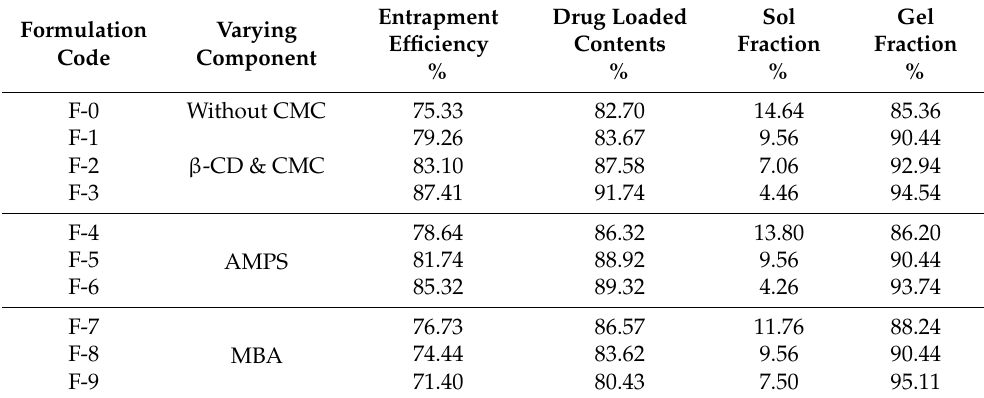
Table 2. %DEE, %DLC, sol and %gel fraction of all synthesized